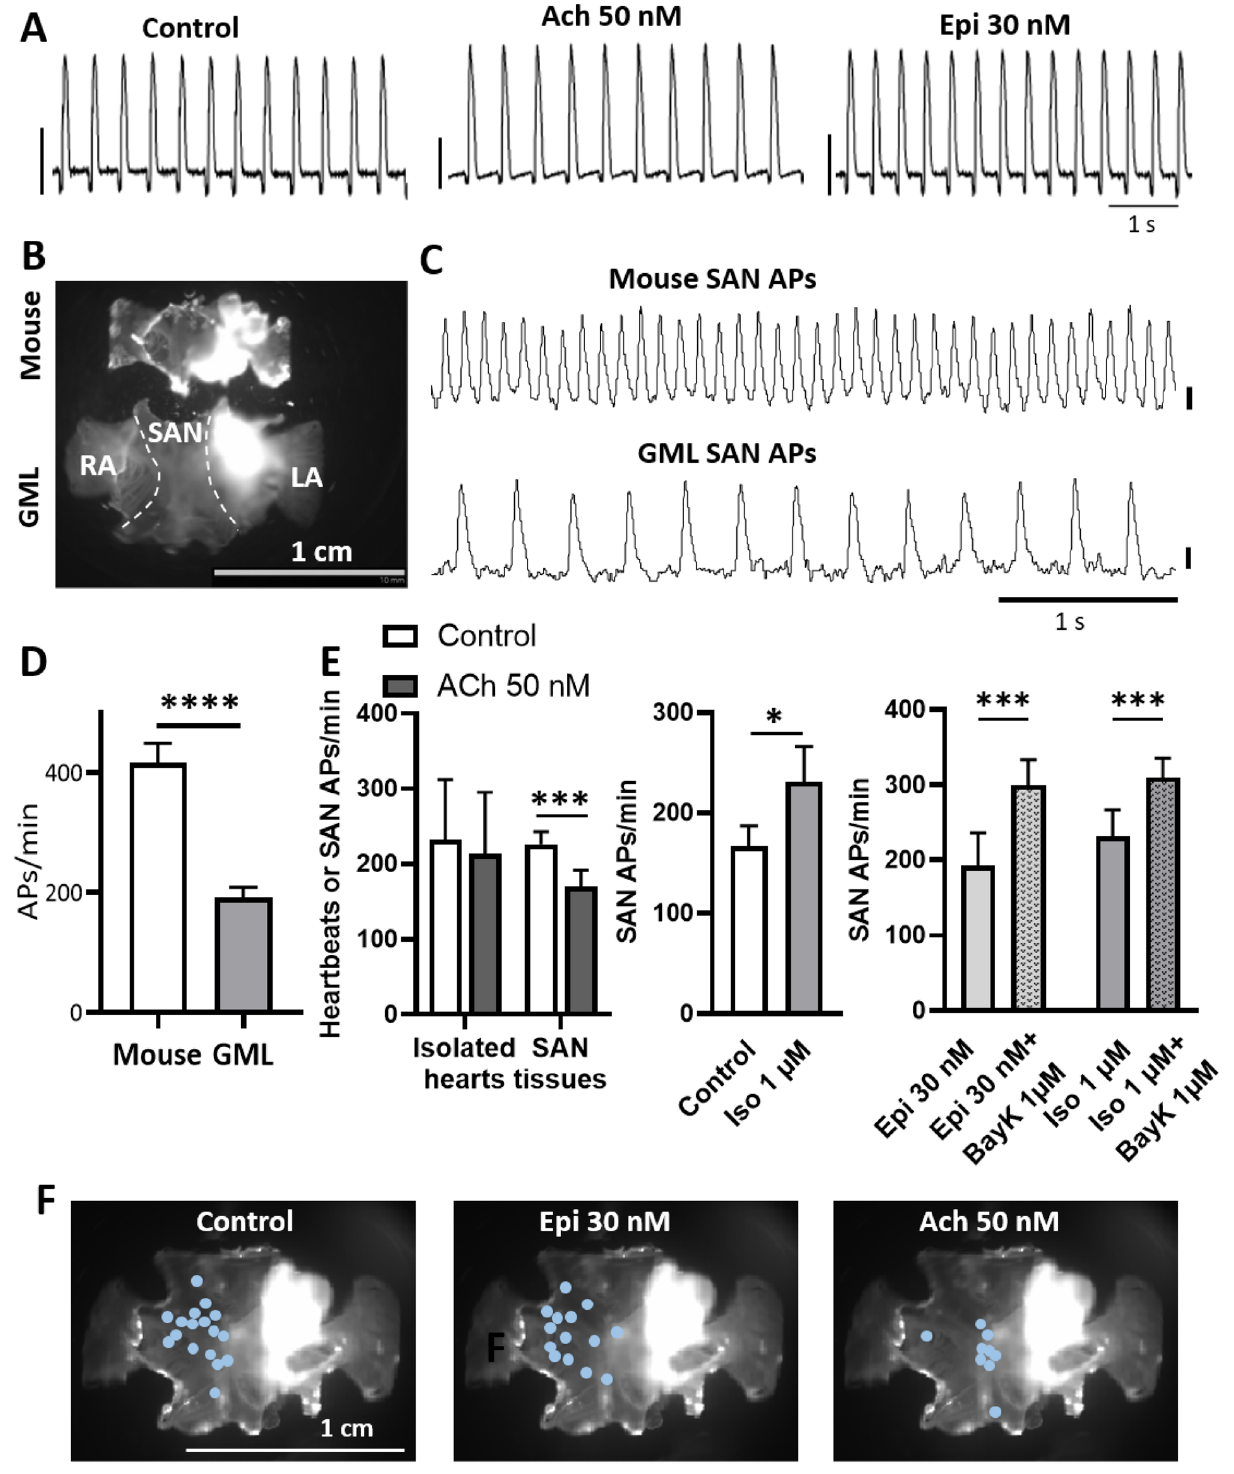
Figure 3. Pacemaker activity of GML isolated hearts and SAN preparations. ( A ) Sample traces of ECGs recorded in isolated hearts from GML, maintained under constant perfusion with a Langendorff system. Traces have been recorded under control conditions (perfusion with Tyrode’s solution), perfusion of acetylcholine (Ach; 50 nM) or epinephrine (Epi; 30 nM). Scale bars correspond to 1 mV. ( B ) Examples of atrial preparations of mice and GML , including the SAN, the right and left atria (RA and LA, respectively). ( C ) Example traces of optical action potentials (APs) recorded in the SAN of mice and GMLs. APs amplitude is expressed in arbitrary units of fluorescence (a.u.), scale bars correspond to 1 a.u. ( D ) Rate of APs recorded in mice and GMLs under control condition (n mice = 13, n GMLs = 17). ( E ) Changes in automatic rate (heartbeats or APs/min), before and after Ach or isoprenaline (Iso) superfusion, or during Epi and Iso superfusion and after addition of Bay K 8644 (BayK), in Langendorff perfused hearts (n = 3) or atrial preparation of GML (n = 11 in ACh, n = 10 in Iso, n = 5 in Epi and Epi + BayK and n = 10 in Iso and Iso + BayK). ( E ) Dots indicating leading pacemaker sites in SAN preparations of GML under control, Epi or Ach perfusion. *p < 0.05, ***p < 0.001 and ****p < 0.0001 by unpaired T-test, paired T-test, two-way Anova and two-way Anova with Sidak’s multi comparison